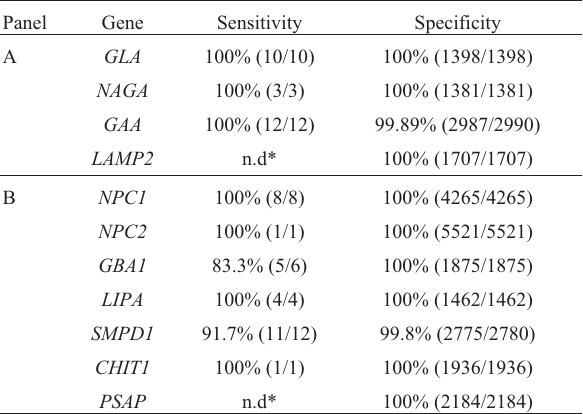
Table 3 - Analytical sensitivity and specificity for each gene in our gene panels. Panel